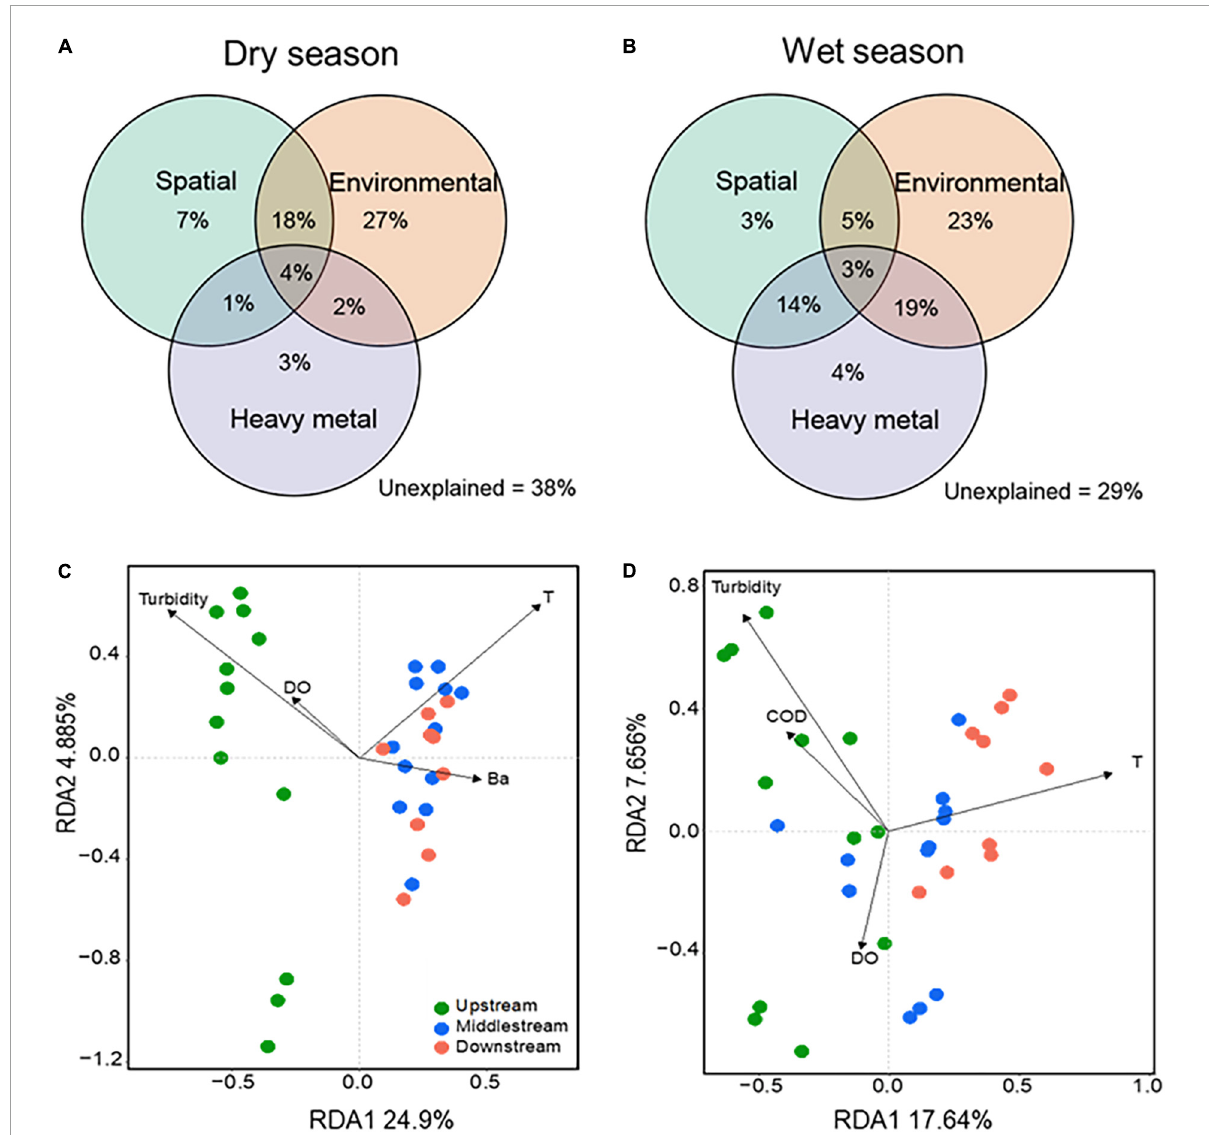
FIGURE4 Drivers of microbial communities. The variation partitioning analysis (VPA) diagrams show the percentage contribution of spatial (river section, latitude, and longitude), environmental factors (pH, Conductivity, T, Turbidity, DO, TN, TP, and COD), and heavy metal (V, Cr, Mn, Fe, Co, Ni, Cu, Zn, Cd, Sb, and Ba) to bacterial community variations in the dry (C) and wet (D) seasons. The redundancy analysis (RDA) biplots show factors impacting bacterial communities in the dry (A) and wet (B) seasons. Dot color indicates samples from different river sections: green, upstream; blue, midstream; red, downstream. Only six factors identified to significantly influence bacterial communities are shown in the RDA plots. T , temperature; COD, chemical oxygen demand; DO, dissolved